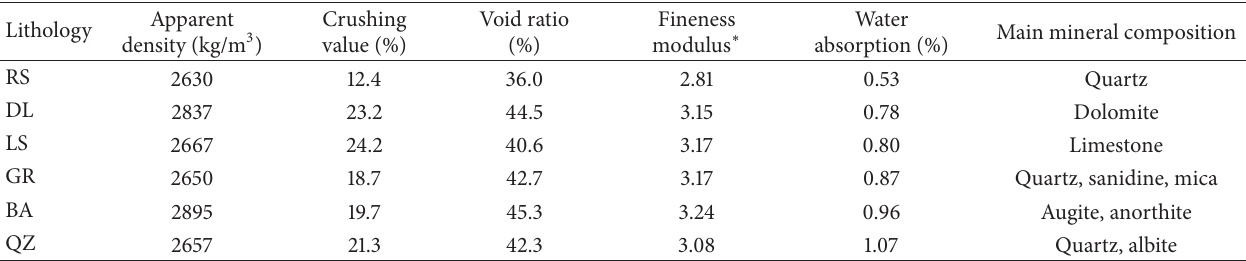
Table 2: Properties of used fine